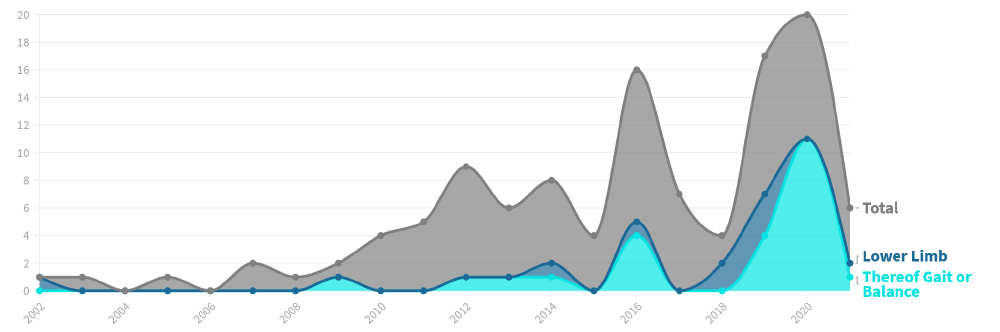
Figure 7. Share of research aimed at Lower Limb